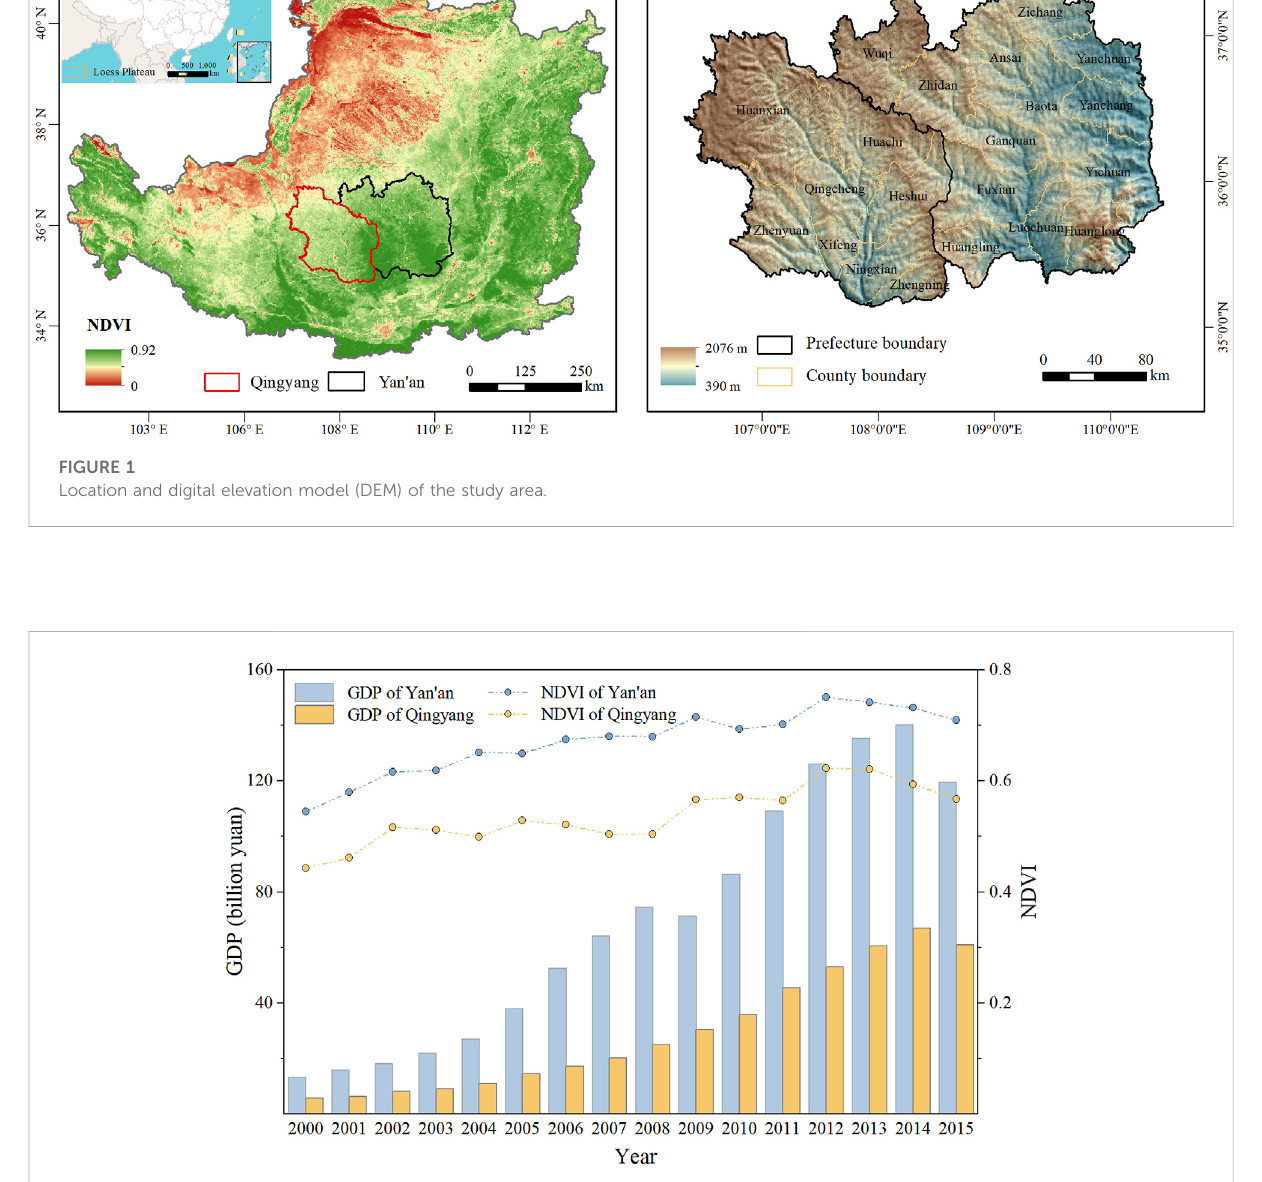
FIGURE 2 Changes in the annual maximum NDVI and GDP of the study area between 2000 and